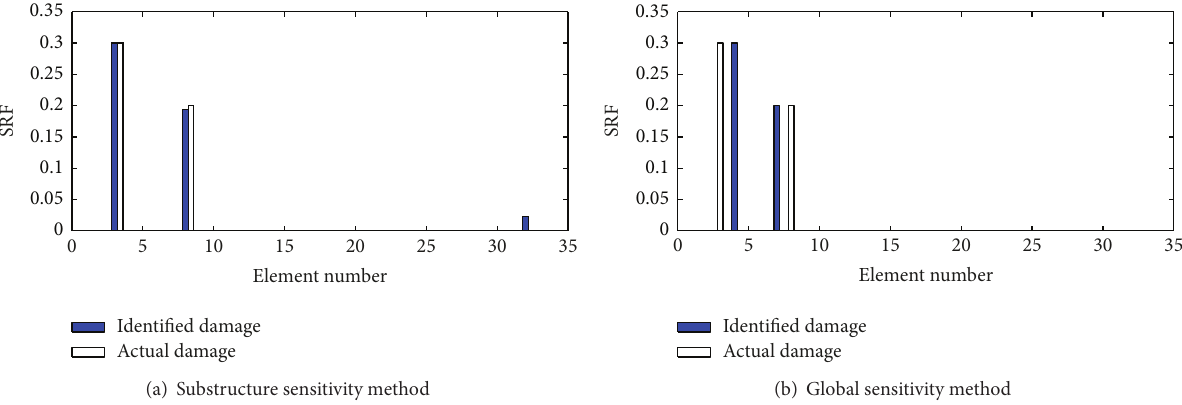
Figure 9: Damage detection results (Case 5).